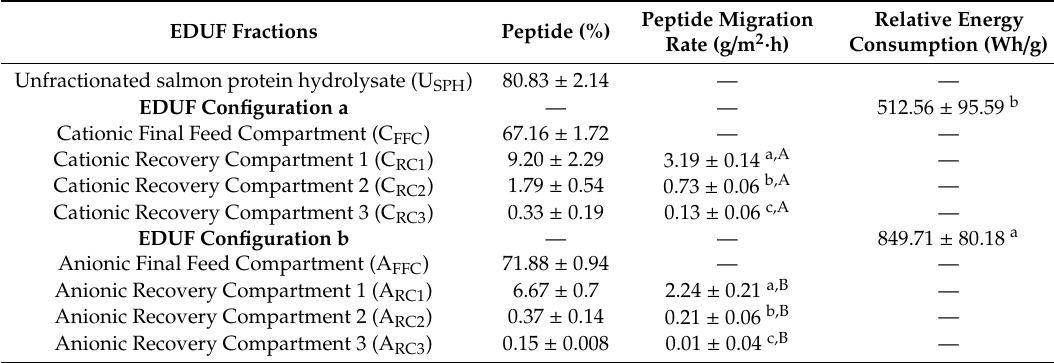
Table 1. The relative energy consumption, peptide migration rate, and peptide concentration in cationic and anionic configuration compartments. Lowercase letters are used to compare the three recovered compartments of the same configuration, means with di ff erent lowercase letters are significantly di ff erent ( p < 0.05). Whereas capital letters are used to compare the recovered compartments between anionic and cationic configuration, means with di ff erent capital letters are significantly di ff erent ( p <